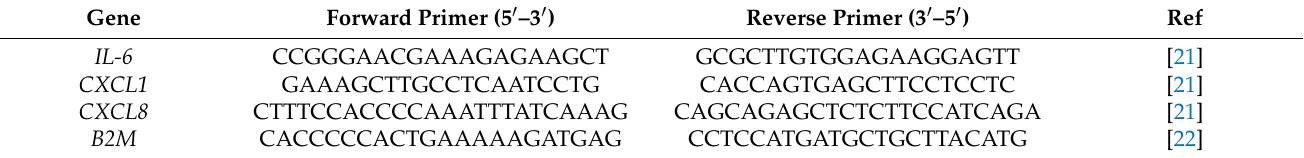
Table 1. Primer sequences used in this